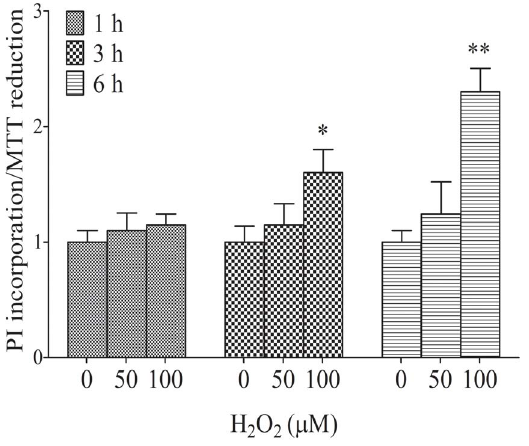
Figure 5. Effects of H 2 O 2 on adult astrocyte cell viability. Membrane integrity (PI incorporation) and metabolic activity (MTT reduction) were measured as described in the Materials and Methods section. The medium was removed, followed by the addition of DMEM/ F12 supplemented with 5% FBS, and the cells were maintained at 5% CO represent the mean 6 S.E. from 4 to 6 experimental determinations performed in triplicate. * P , 0.05 and ** P , 0.01 indicate